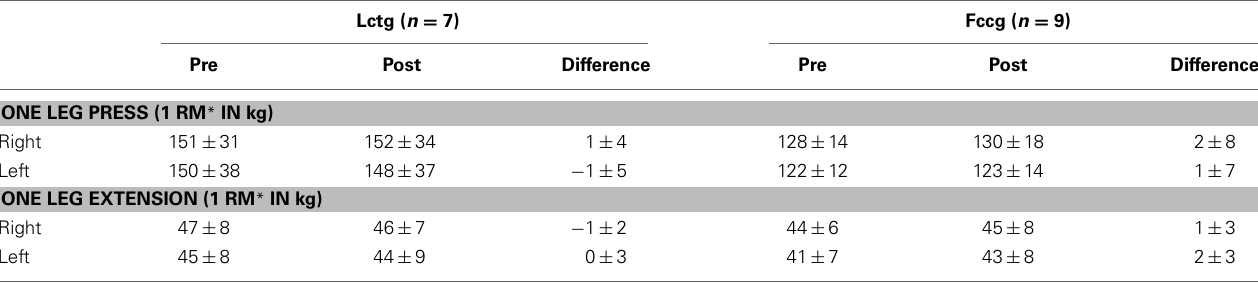
Table 5 | Leg strength (mean ± SD ) pre and post training intervention period for the low cadence training group (Lctg) and the freely chosen cadence group